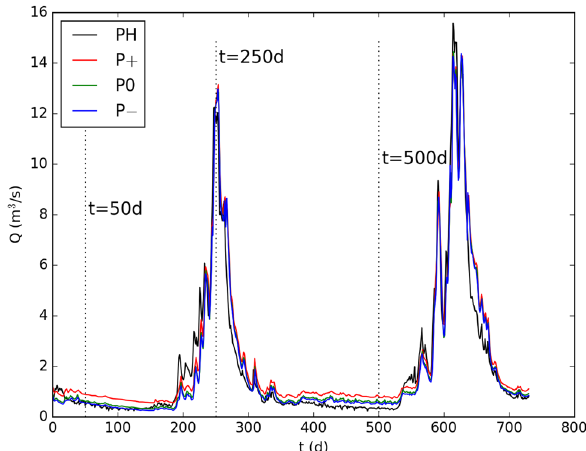
Figure 4. Model discharge predictions at PH for different model variations. Dashed lines indicate t = 50, 250, 500 d , where snapshots of distributed hydrological response is plotted in Figs. 2 and 3.